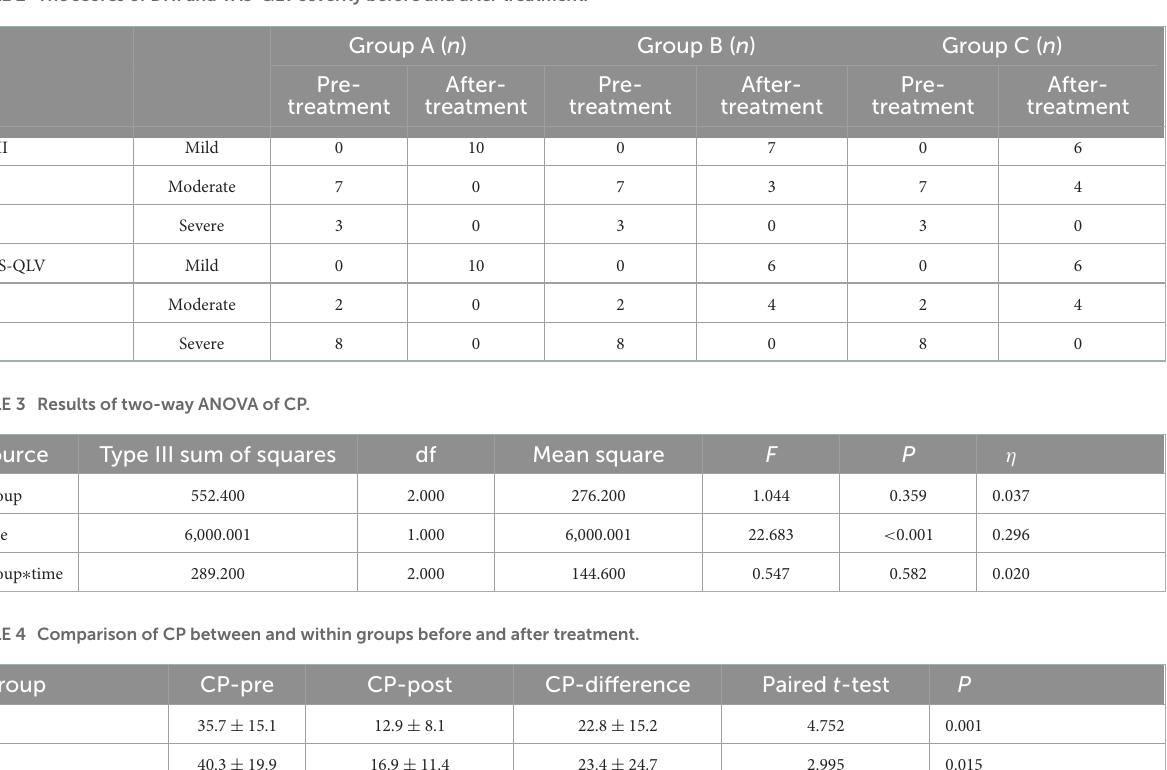
TABLE 2 The scores of DHI and VAS-QLV severity before and after treatment.